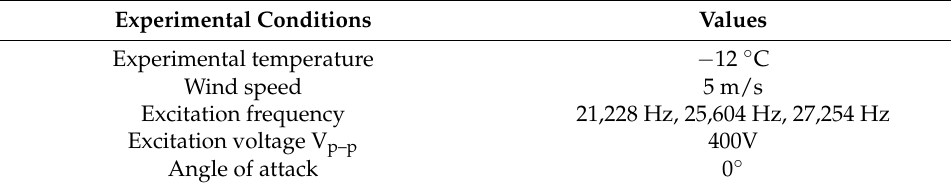
Table 3. Experimental scheme on the icing test of the airfoil